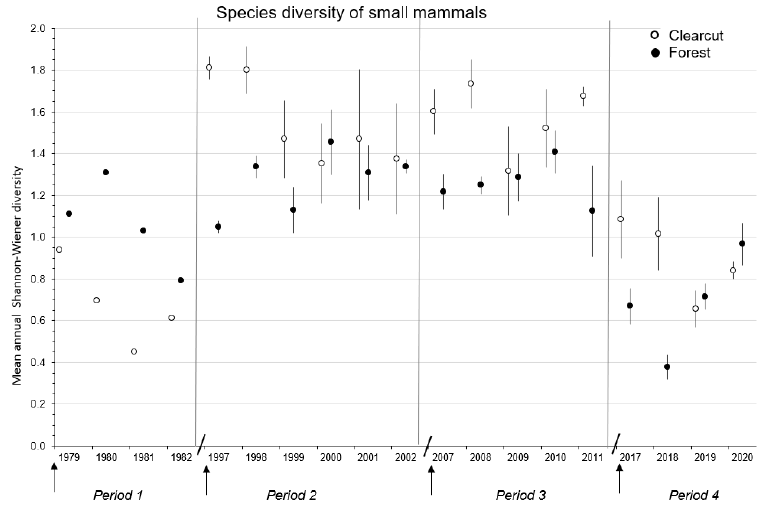
Figure 3. Mean ( n = 1, 3, or 4 replicate sites) ± SE annual species diversity of forest-floor small mammals in the first four to six complete years in clearcut and uncut forest sites during the Periods 1979–1982, 1997–2002, 2007–2011, and 2017–2020 for the CC-FOR study in southern British Columbia, Canada. Arrow indicates time of harvesting on clearcut sites. Diagonal line separates Periods .